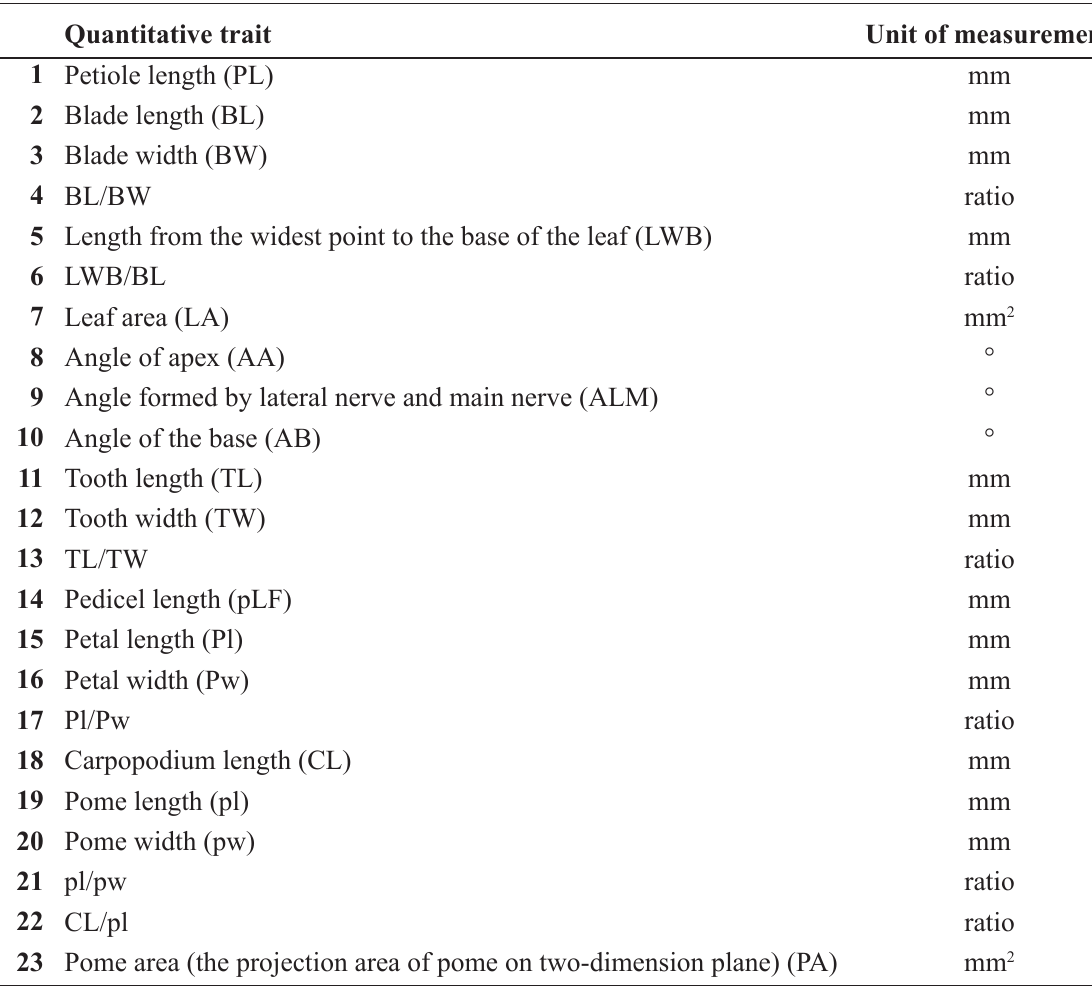
Table 1. Description of the quantitative and qualitative morphological parameters of species of Malus